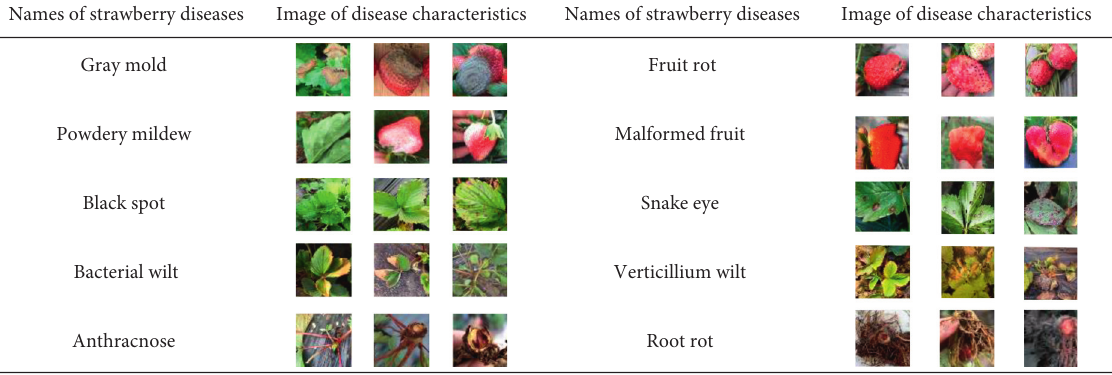
Figure 3: Examples of typical strawberry disease